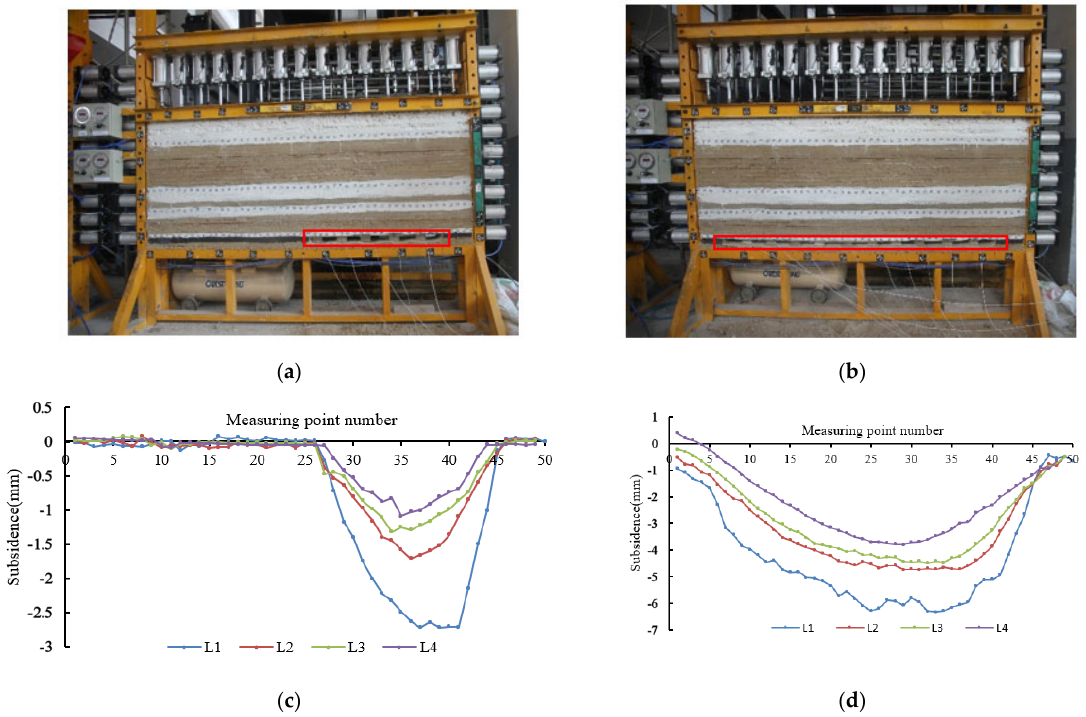
Figure 11. Overburden subsidence curves of 4 cm mining height physical model: ( a ) 102 cm mining width; ( b ) 204 cm mining width; ( c ) subsidence curves of 102 cm mining width; ( d ) subsidence curves of 204 cm mining width.